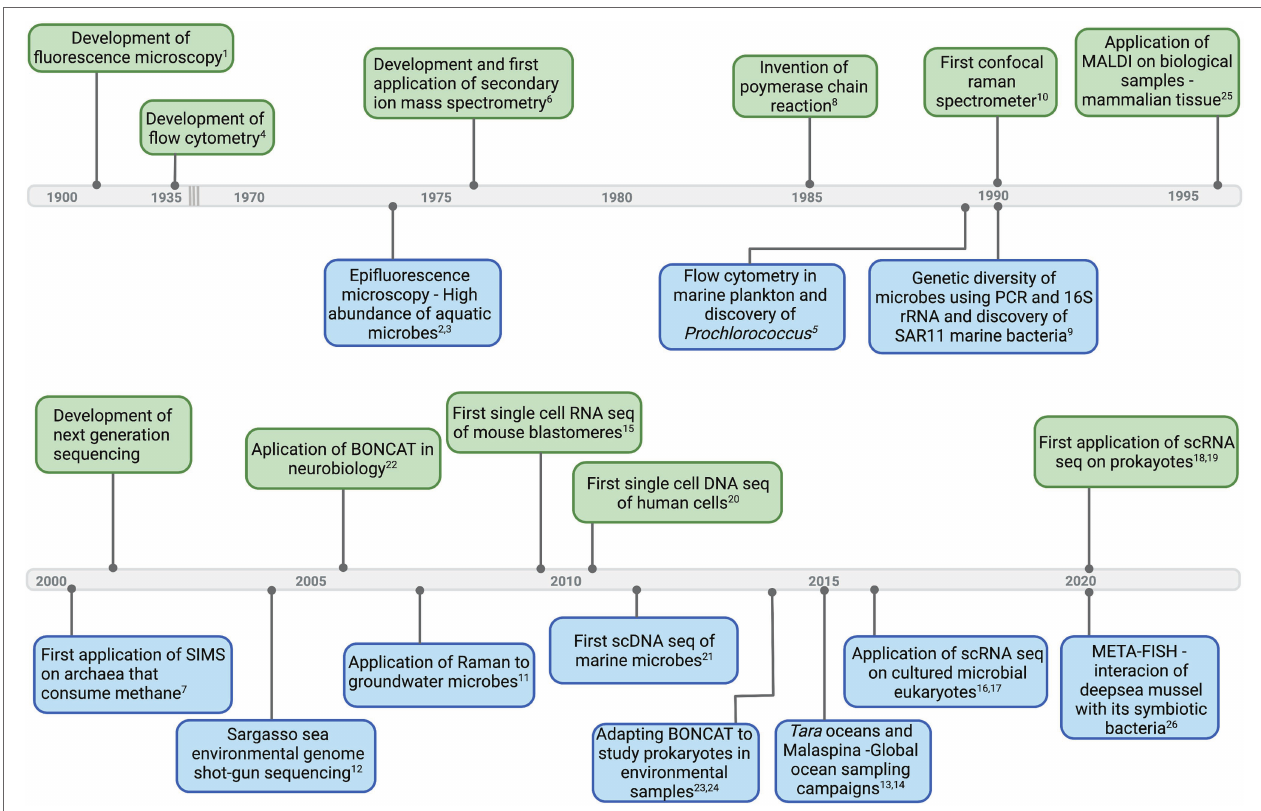
FIGURE 1 | Timeline of select major developments in instruments and technologies (upper side of the timeline—light green) that led to first applications and important breakthroughs in aquatic microbial ecology (down side of the timeline—light blue). Corresponding references: 1 (Renz, 2013), 2 (Francisco et al.,